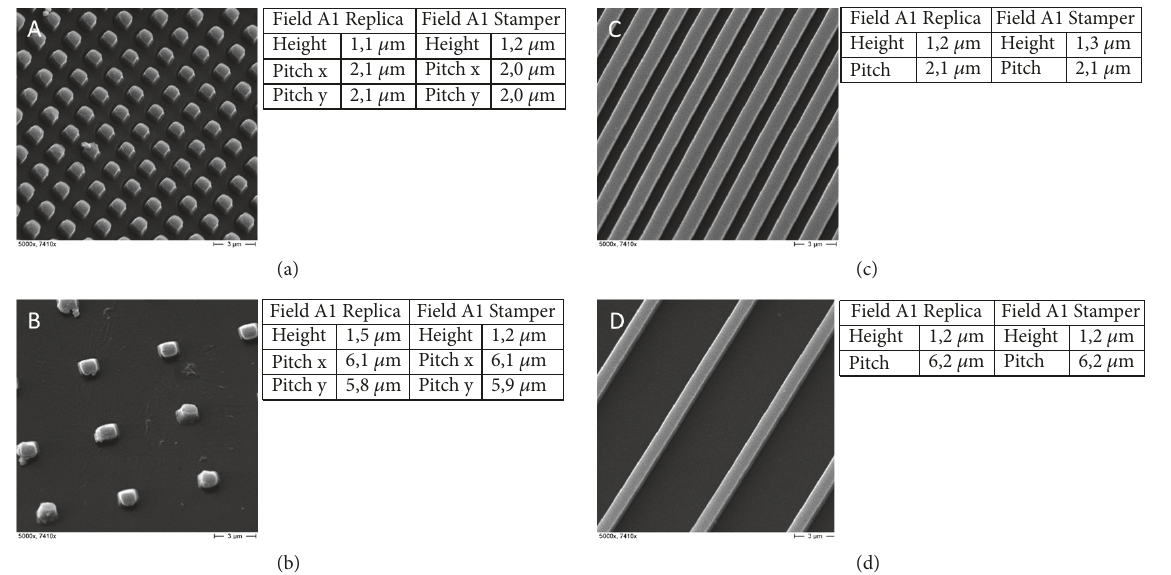
Figure 1: (a)-(d): SEM images of the injection-molded microstructures (left images) and the AFM profile measurements of the injection- molded microstructures compared according to the stamper (right tables). Pitch measured from center point to center point of structure elements. (a) Cubes P1:1; (b) cubes P1:5; (c) walls P1:1; (d) walls